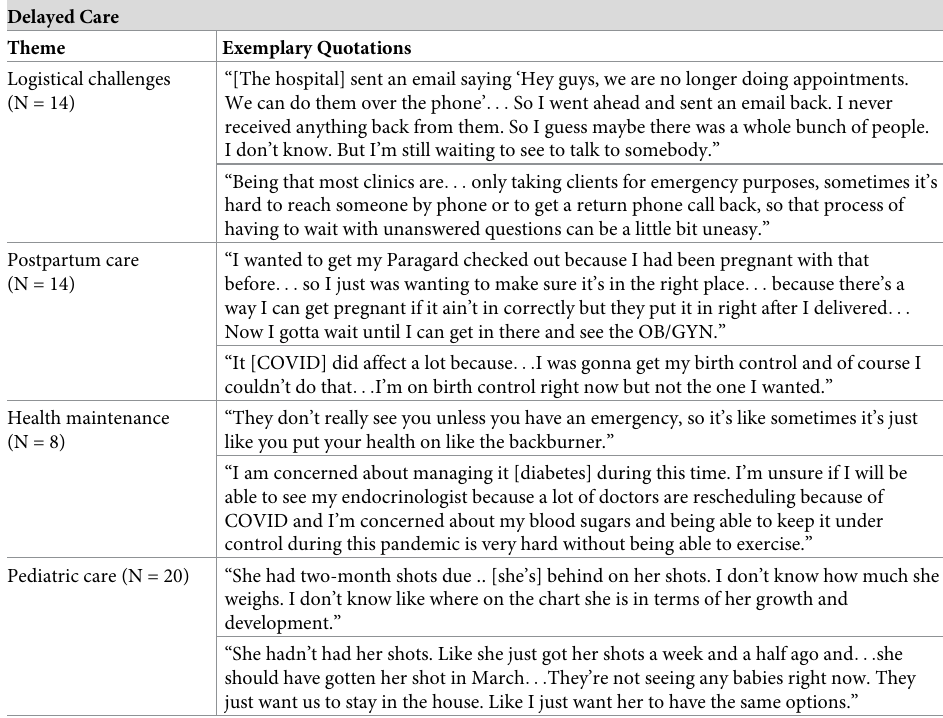
Table 4. Perceptions of participants on healthcare delays during the COVID-19